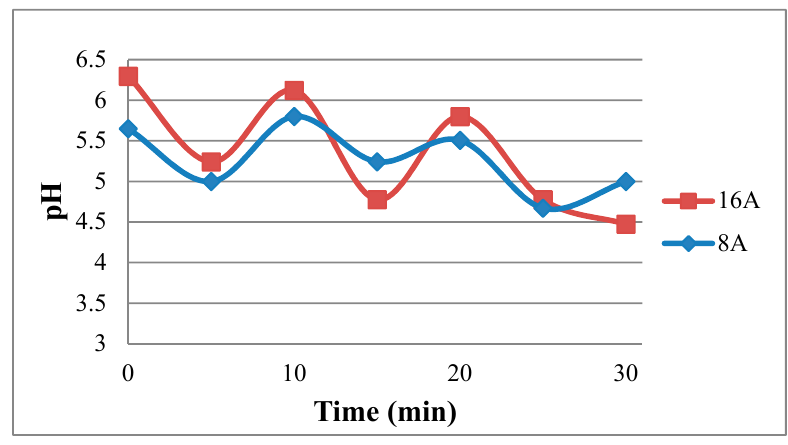
Figure 16. Real-time measurement of pH.